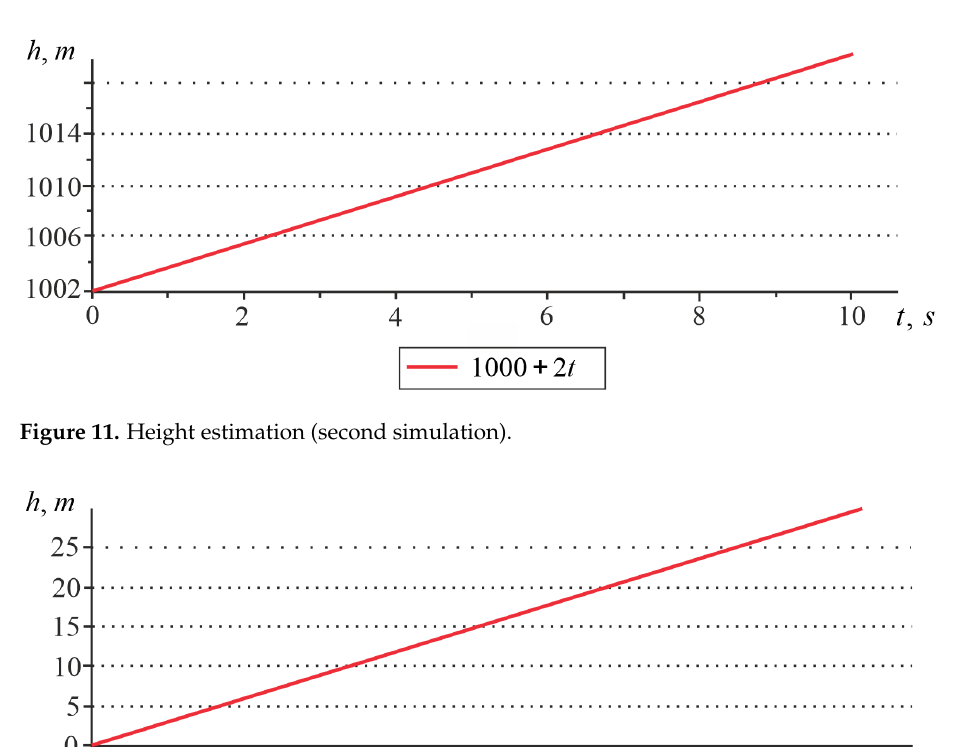
Figure 10. Estimates of the velocity vector components (second simulation).